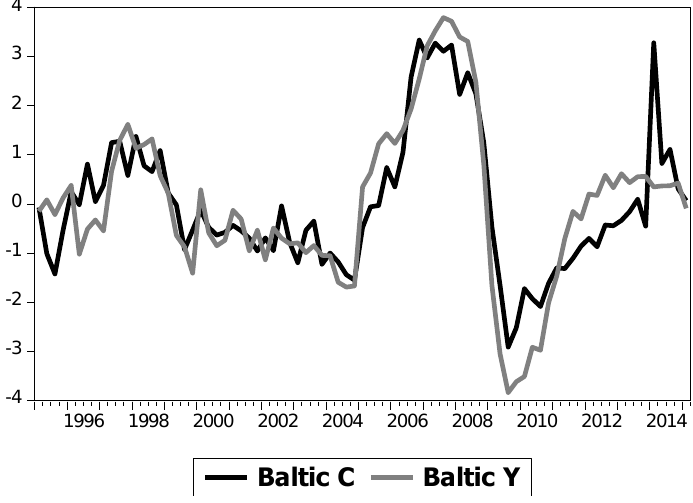
Fig. 3. Baltic output and consumption common